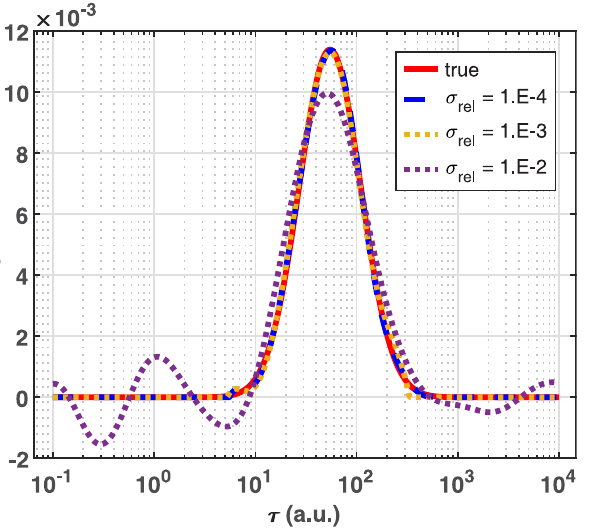
Fig 11. Comparison of the true distribution (copied from S3B Fig) to those predicted by the selected models. The model selection by BO based on 10-fold CV (Fig 9 right column) was carried out on the simulated data (Fig 8 blue) at different noise levels.